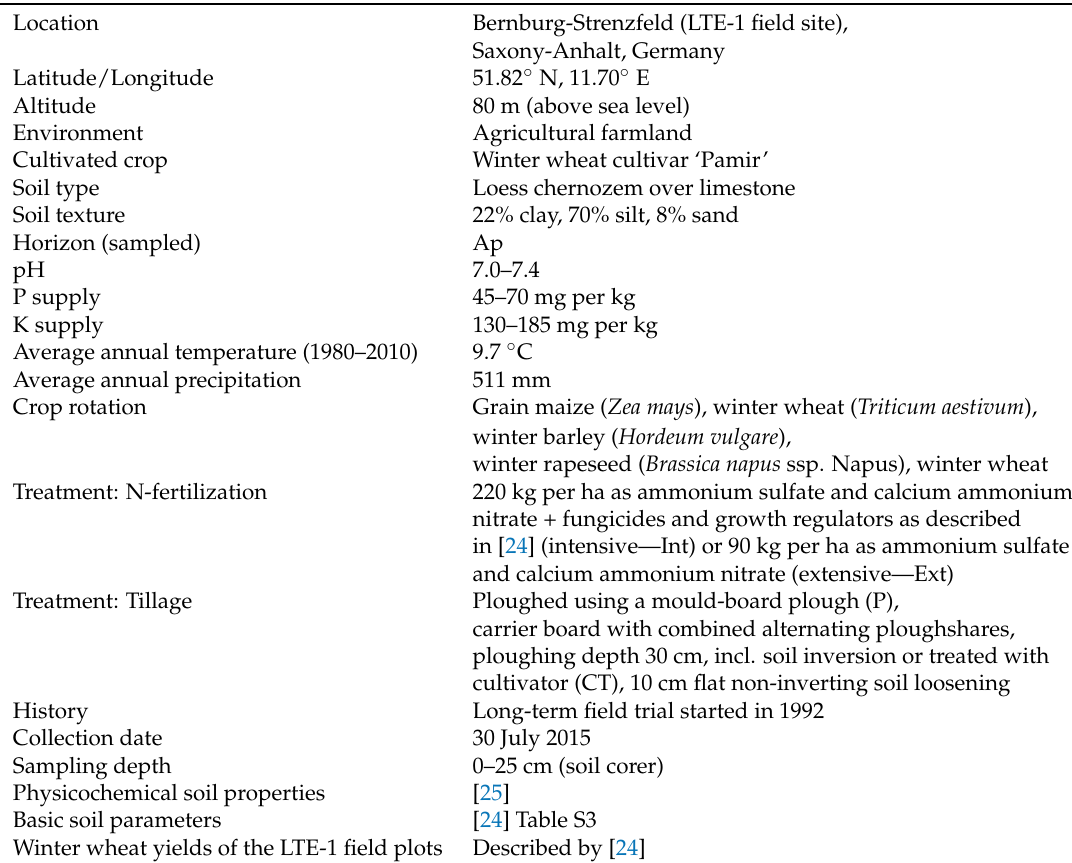
Metadata for the Long-Term-Experiment (LTE-1) field site at Bernburg-Strenzfeld (Saxony-Anhalt, Germany). Data taken from Sommermann et al.